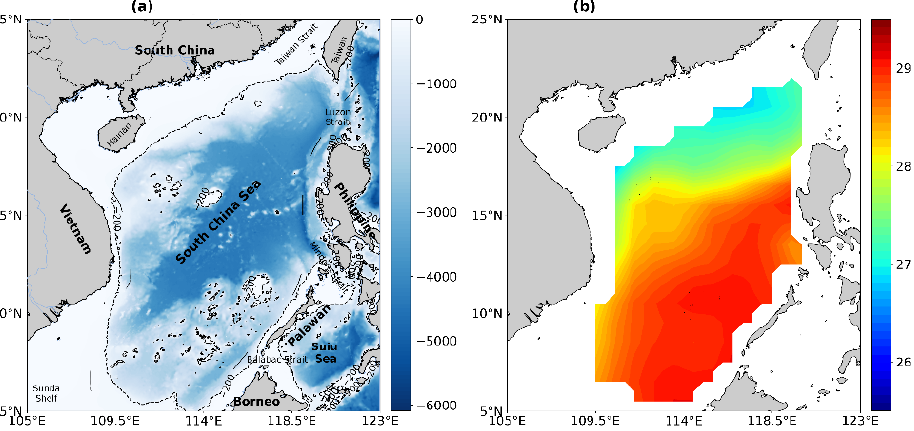
Figure 1. ( a ) Bathymetry (m), and ( b ) long-term mean (from January 2010 to December 2019) SST from Argo data in the South China Sea.